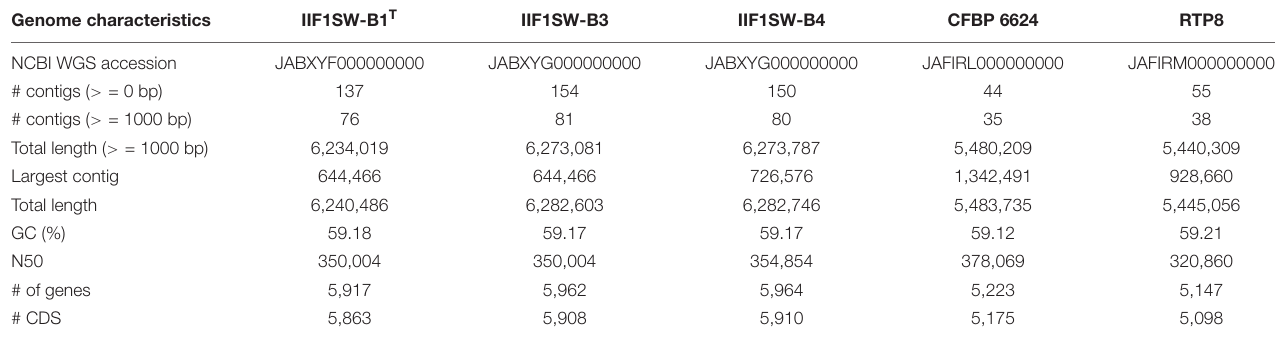
TABLE 1 | Summary of the draft whole-genome sequences of several Agrobacterium tomkonis strains. Genome